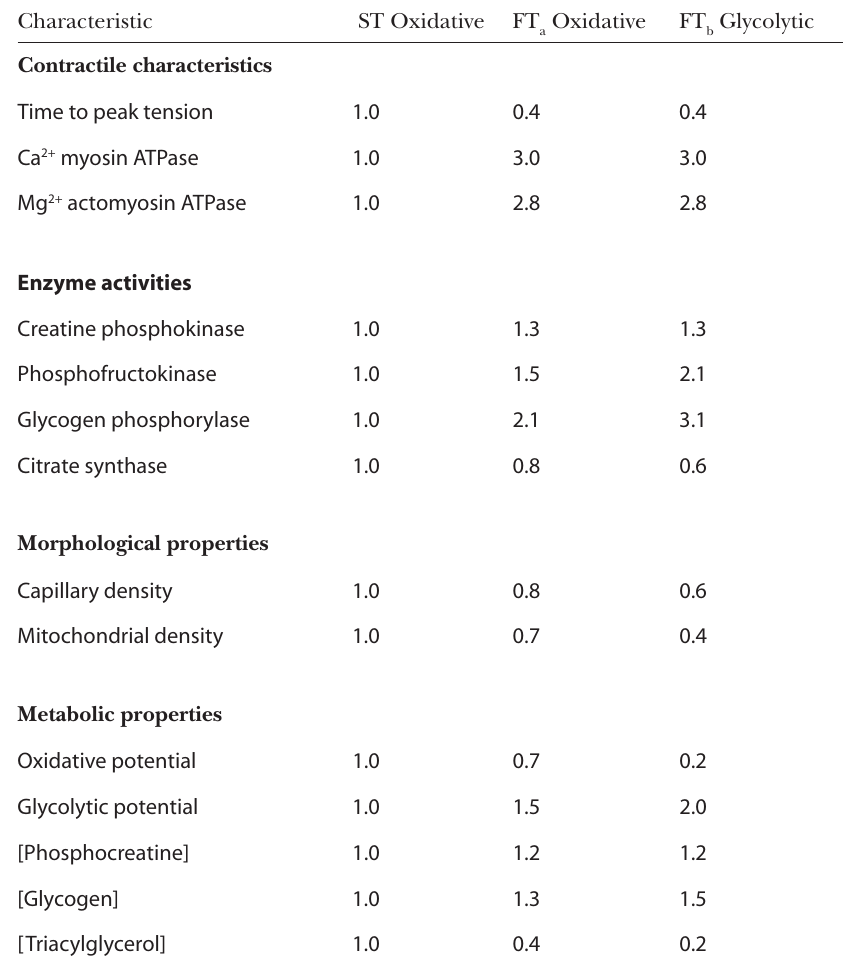
Table 1. Contractile Characteristics, Selected Enzyme Activities, and